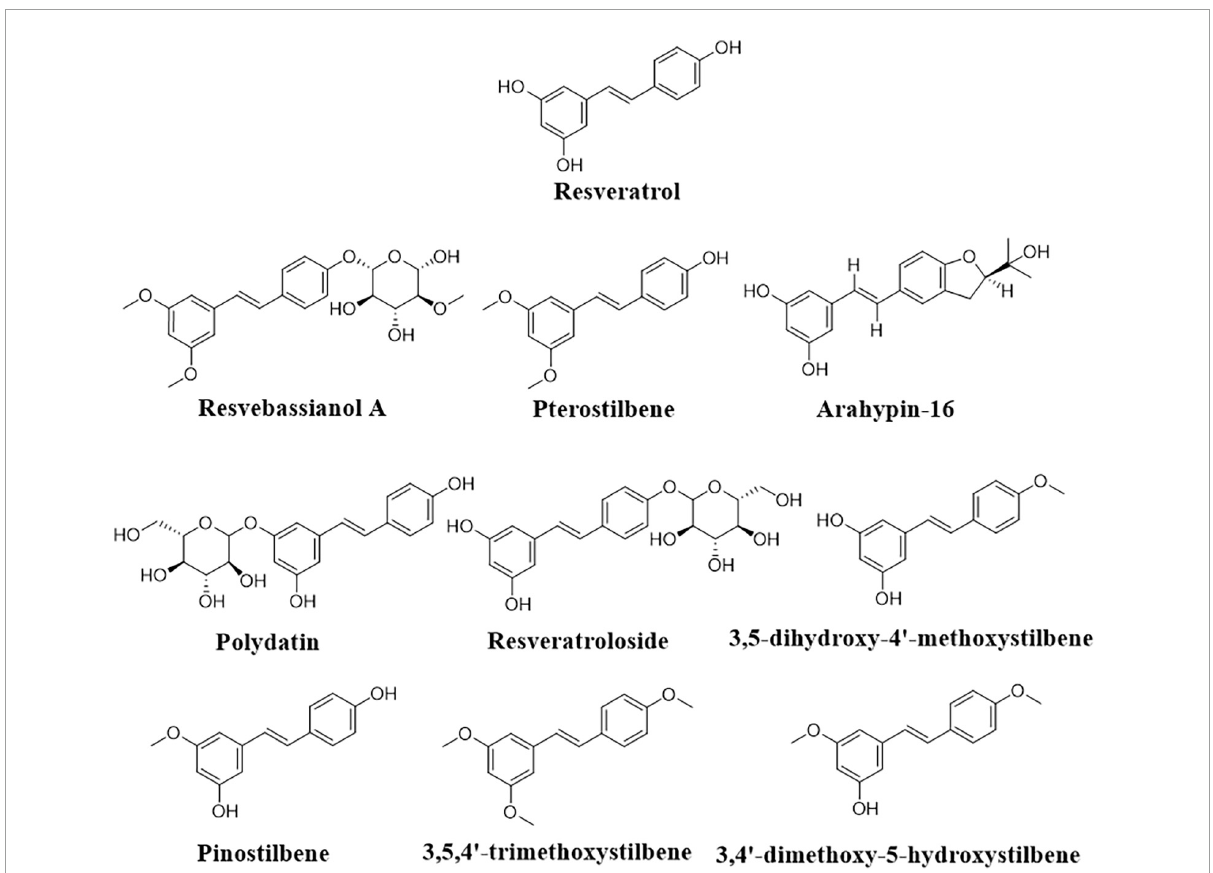
FIGURE5 Representative structure of resveratrol biotransformed